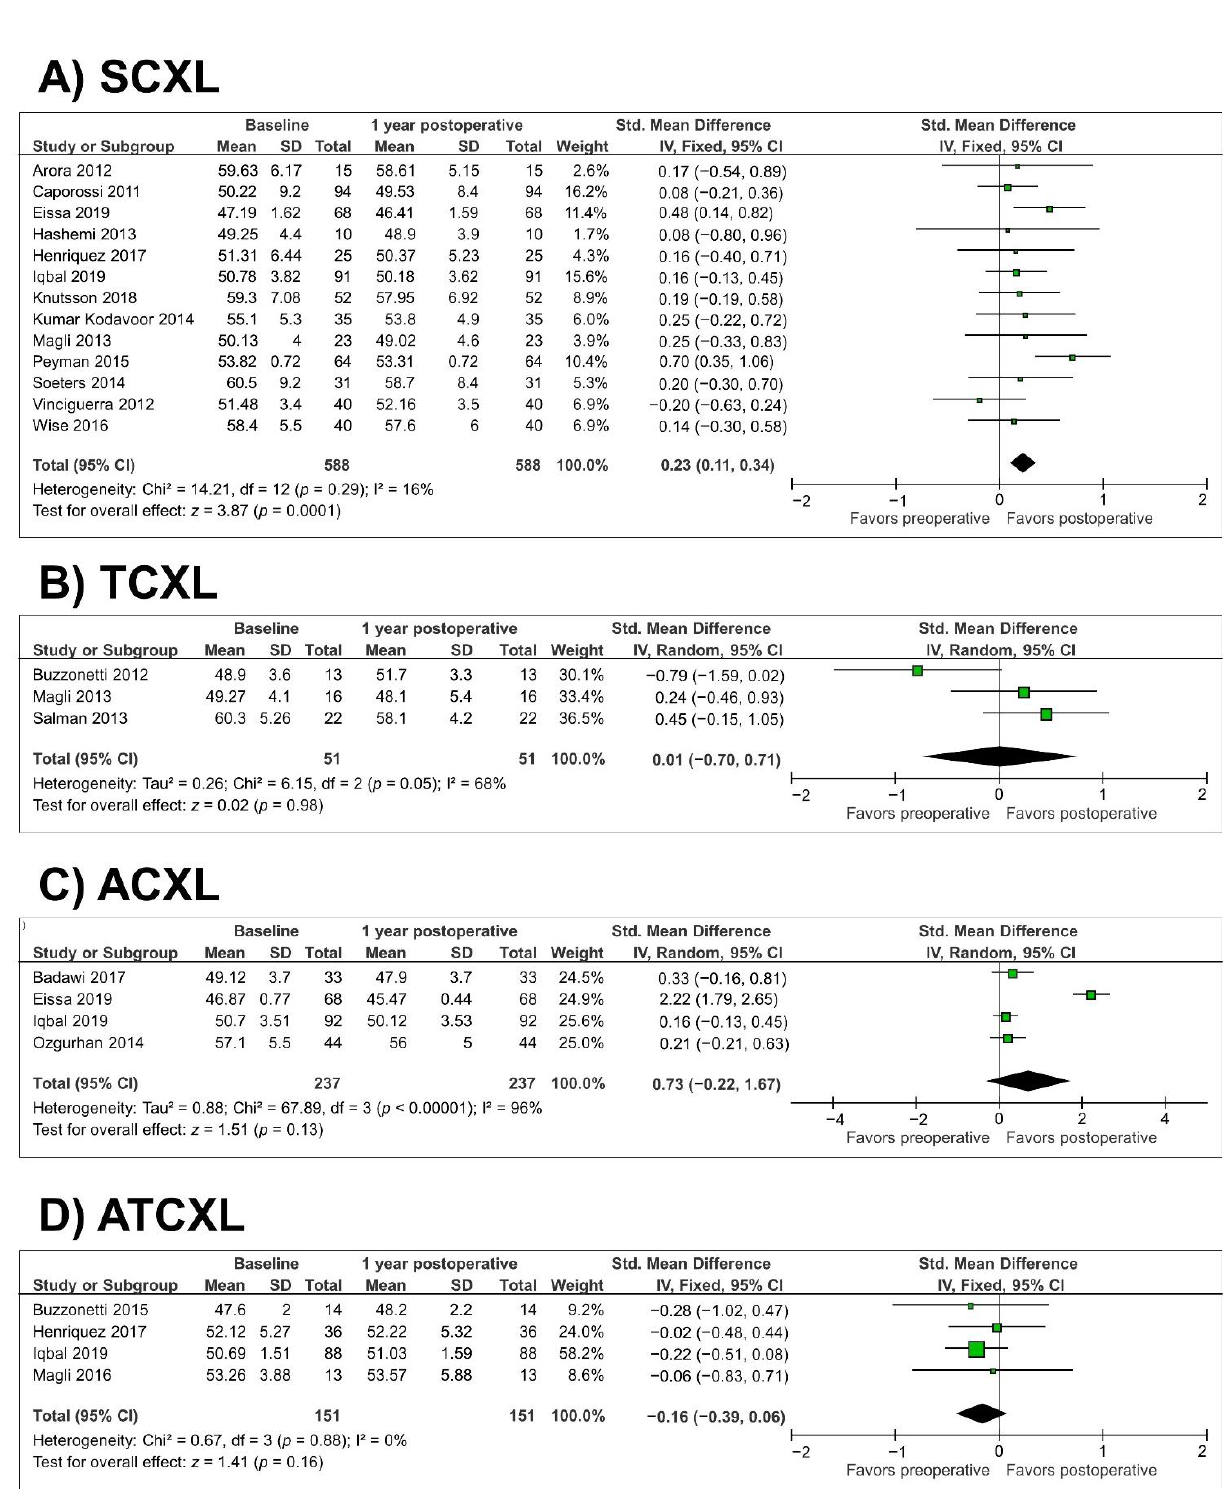
Figure 2. Forest plot of maximum keratometry (Kmax) 1-year standardized mean differences in dioptres in studies included in meta-analysis. ( A ), standard cross-linking (SCXL); ( B ), accelerated CXL (ACXL); ( C ), transepithelial CXL (TCXL); ( D ), accelerated and transepithelial CXL (ATCXL). IV = inverse variance, CI = confidence interval, Tau 2 = tau-square statistic, Chi 2 = chi-square statistic, df = degrees of freedom, I 2 = I-square heterogeneity statistic, z = Z-statistic.